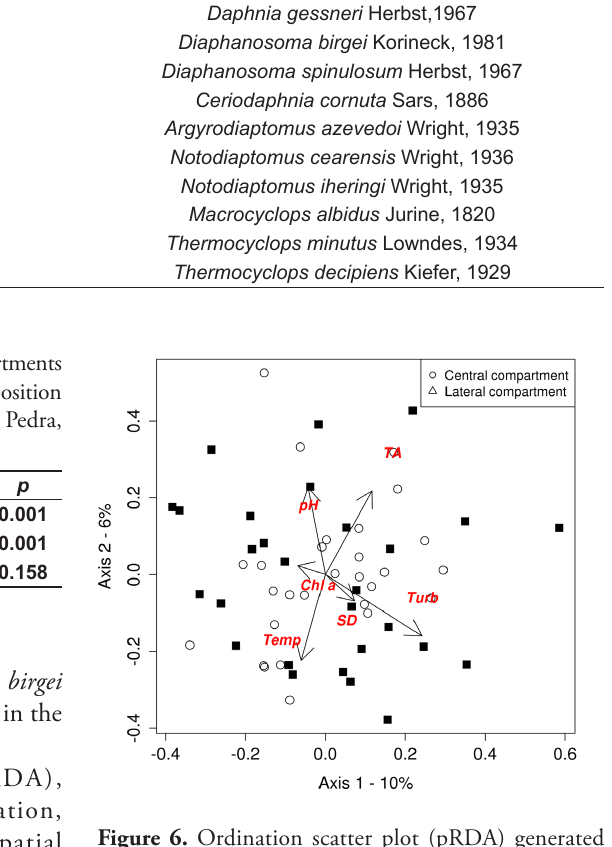
Figure 6. Ordination scatter plot (pRDA) generated from six abiotic variables (Turb: turbidity; SD: Secchi disk; TA: total alkalinity; Chl a: chlorophyll- a ; Temp: temperature, pH) and abundance of sampled microcrustaceans between July 2013 and November 2014 of the reservoir Barragem da Pedra, Jequié,